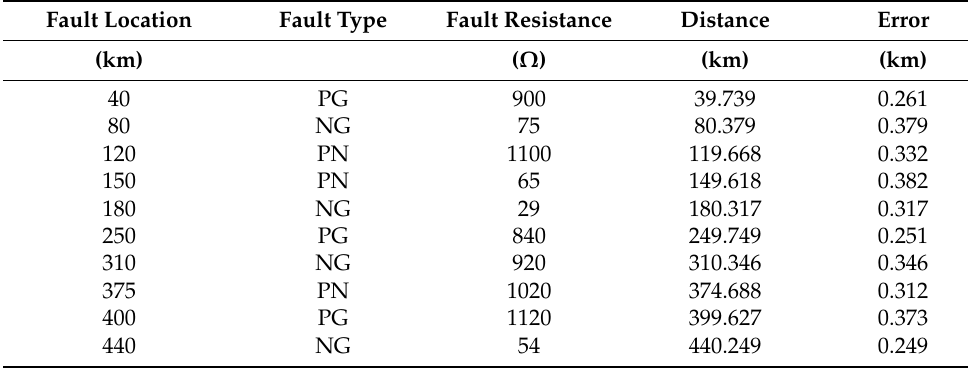
Figure 21. Hybrid three-segment VSC-HVDC system. Table 4. Experimental results on hybrid three-segment